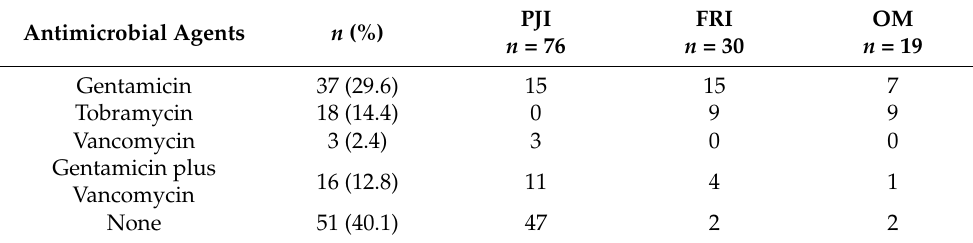
Table 4. Use of local antimicrobial